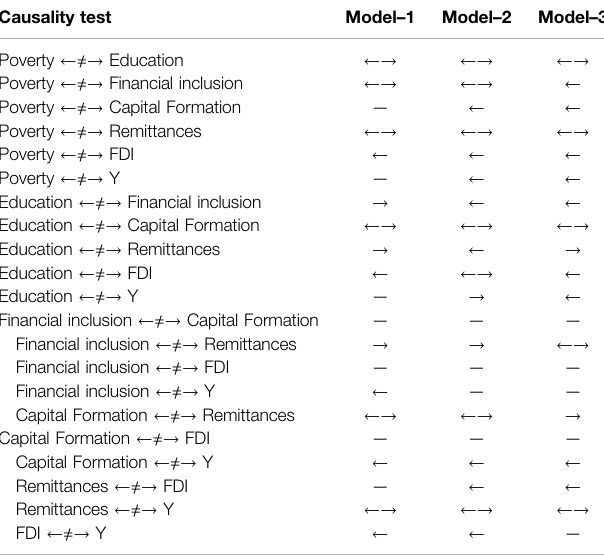
TABLE 12 | Summary of directional causalities in the empirical